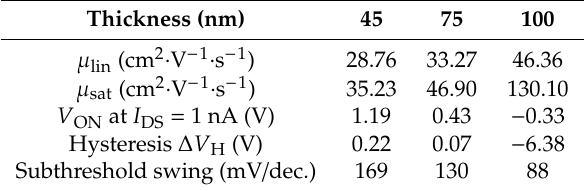
Figure 2. Transfer characteristics of TFT devices with di ff erent T ITZO of ( a ) 45, ( b ) 75, and ( c ) 100 nm evaluated at a V DS of 0.1 and 20.1 V. Table 1. The electrical parameters of a-ITZO TFTs with various T ITZO extracted from the forward